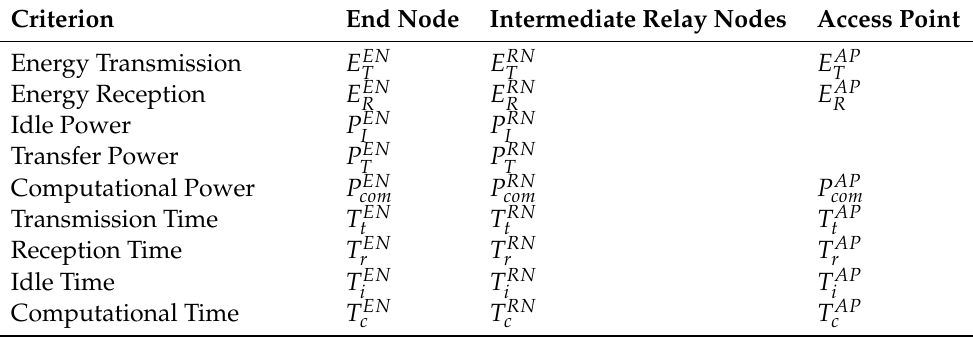
Table 5. Characteristics of